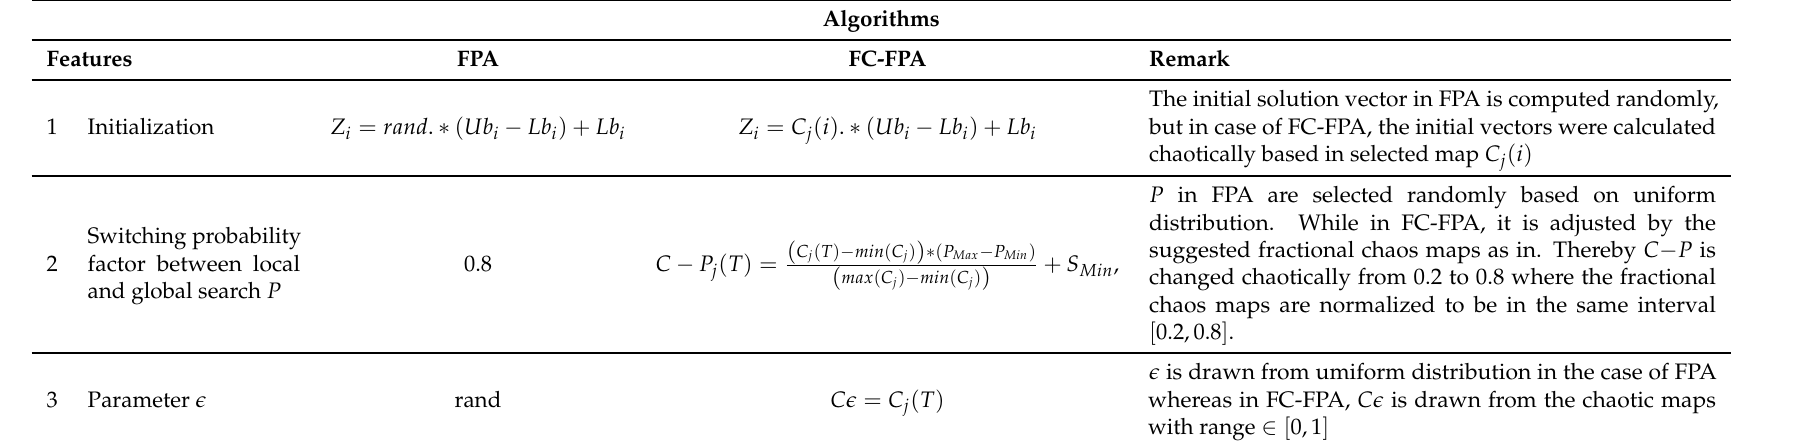
Table 3. Main difference between FPA and FC-FPA based on